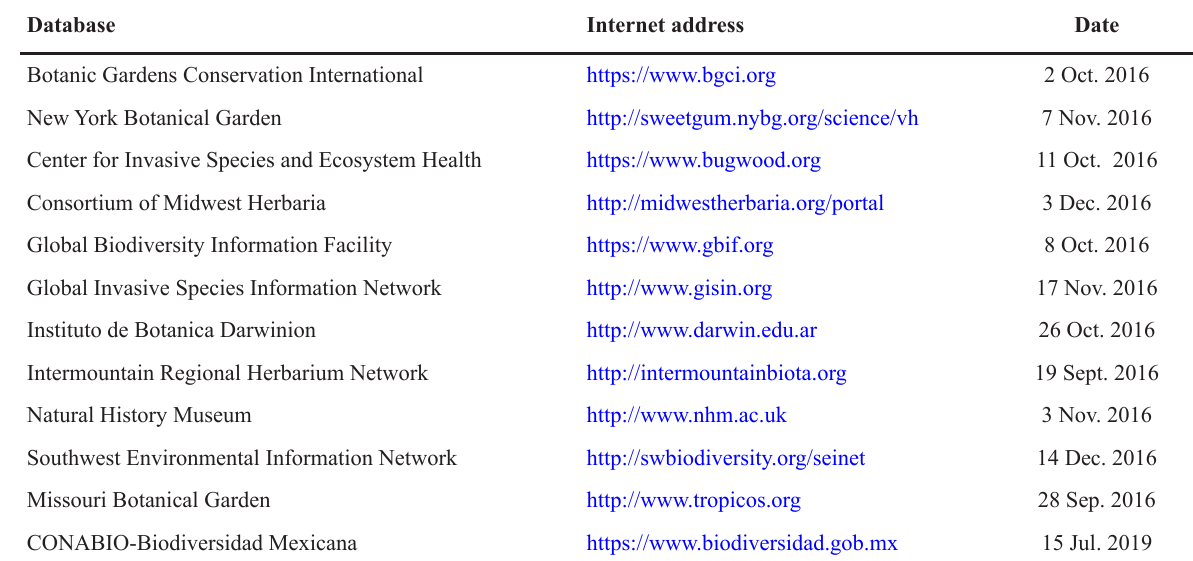
Table 1 – Databases consulted to gather occurrence points of Peruvian peppertrees. The table indicates that name of the name of the database provider, its webpage and the consulting